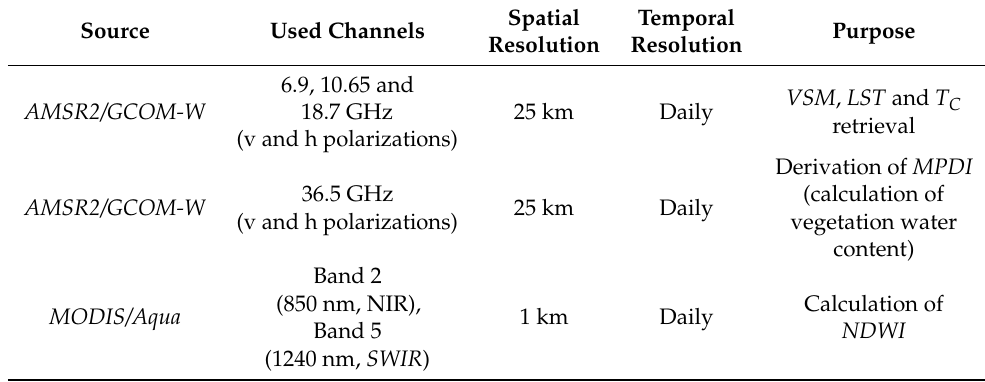
Table 1. Details about the satellite datasets used in this